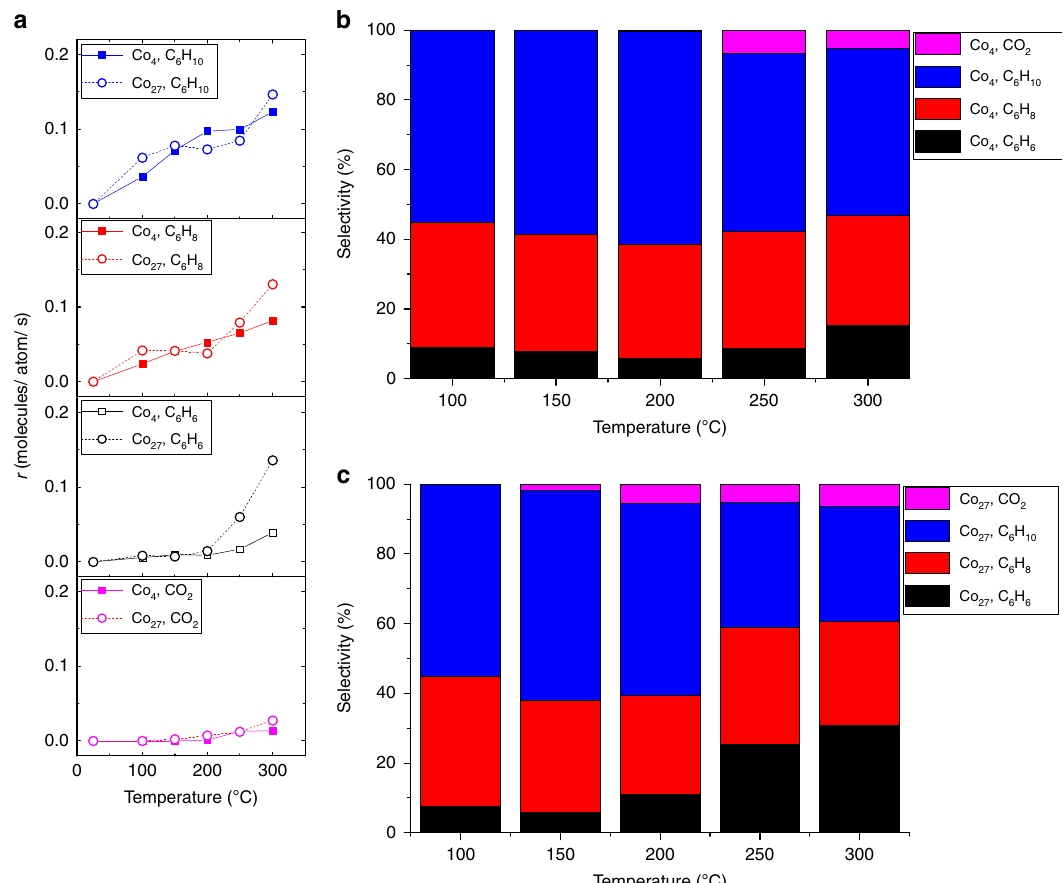
Fig. 3 Performance of alumina-supported Co clusters under oxygen lean conditions (C 6 H 12 :O 2 = 10:1). a r (rate of formation) for the major products cyclohexene (m/z = 67) on the Co 4 /Al 2 O 3 catalyst (blue squares) and Co 27 /Al 2 O 3 catalyst (blue circles), cyclohexadiene (m/z = 79) on the Co 4 /Al 2 O 3 catalyst (red squares) and Co 27 /Al 2 O 3 catalyst (red circles), benzene (m/z = 78) on Co 4 /Al 2 O 3 catalyst (black squares) and Co 27 /Al 2 O 3 catalyst (black circles), and the byproduct CO 2 (m/z = 44) on the Co 4 /Al 2 O 3 catalyst (pink squares) and Co 27 /Al 2 O 3 catalyst (pink circles). Cyclohexadiene mass is a superposition from 1,3- and 1,4- cyclohexadiene (both isomers have same electron ionization cross section 53 ). b Carbon-based selectivity for the dominant reaction products with Co 4 /Al 2 O 3 catalyst (blue: cyclohexene, red: cyclohexadiene, black: benzene, pink: CO 2 ), and c Carbon-based selectivity for the dominant reaction products for Co 27 /Al 2 O 3 catalyst (blue: cyclohexene, red: cyclohexadiene, black: benzene, pink: CO 2 ). The interconnecting lines serve as guide to the